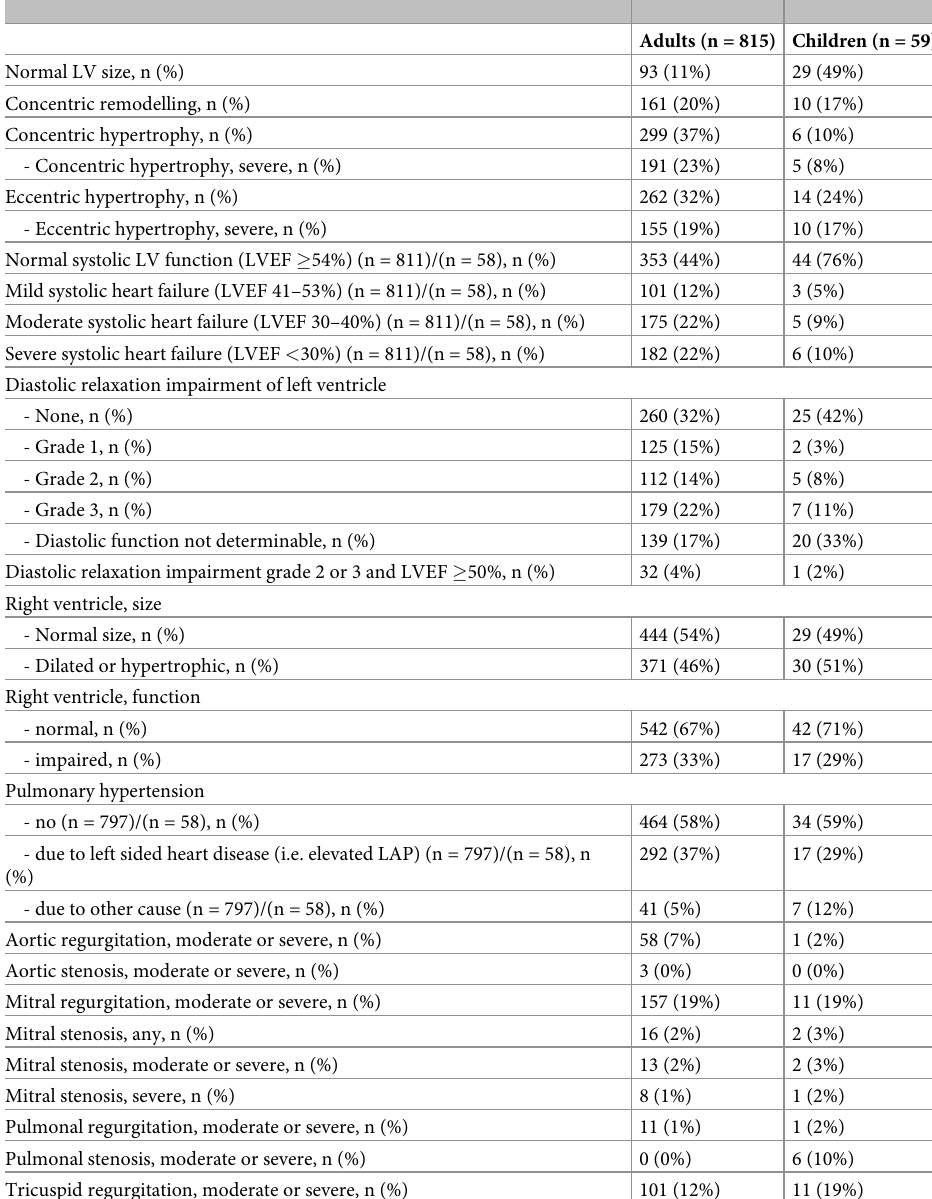
Table 2. Interpretation of echocardiographic